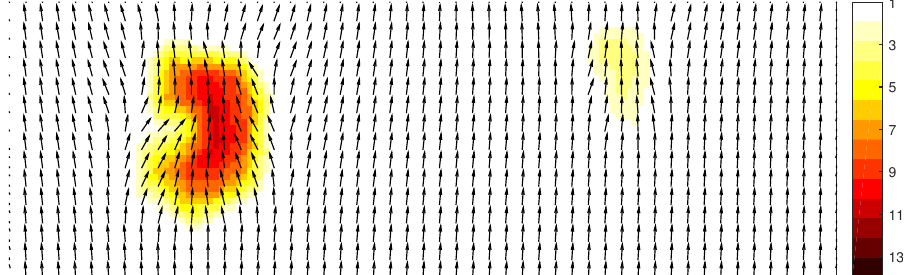
Figure 9. Spatial distribution of total variance (in m 2 ) and vector plot of mean wave direction obtained with scheme FVM-Roe.